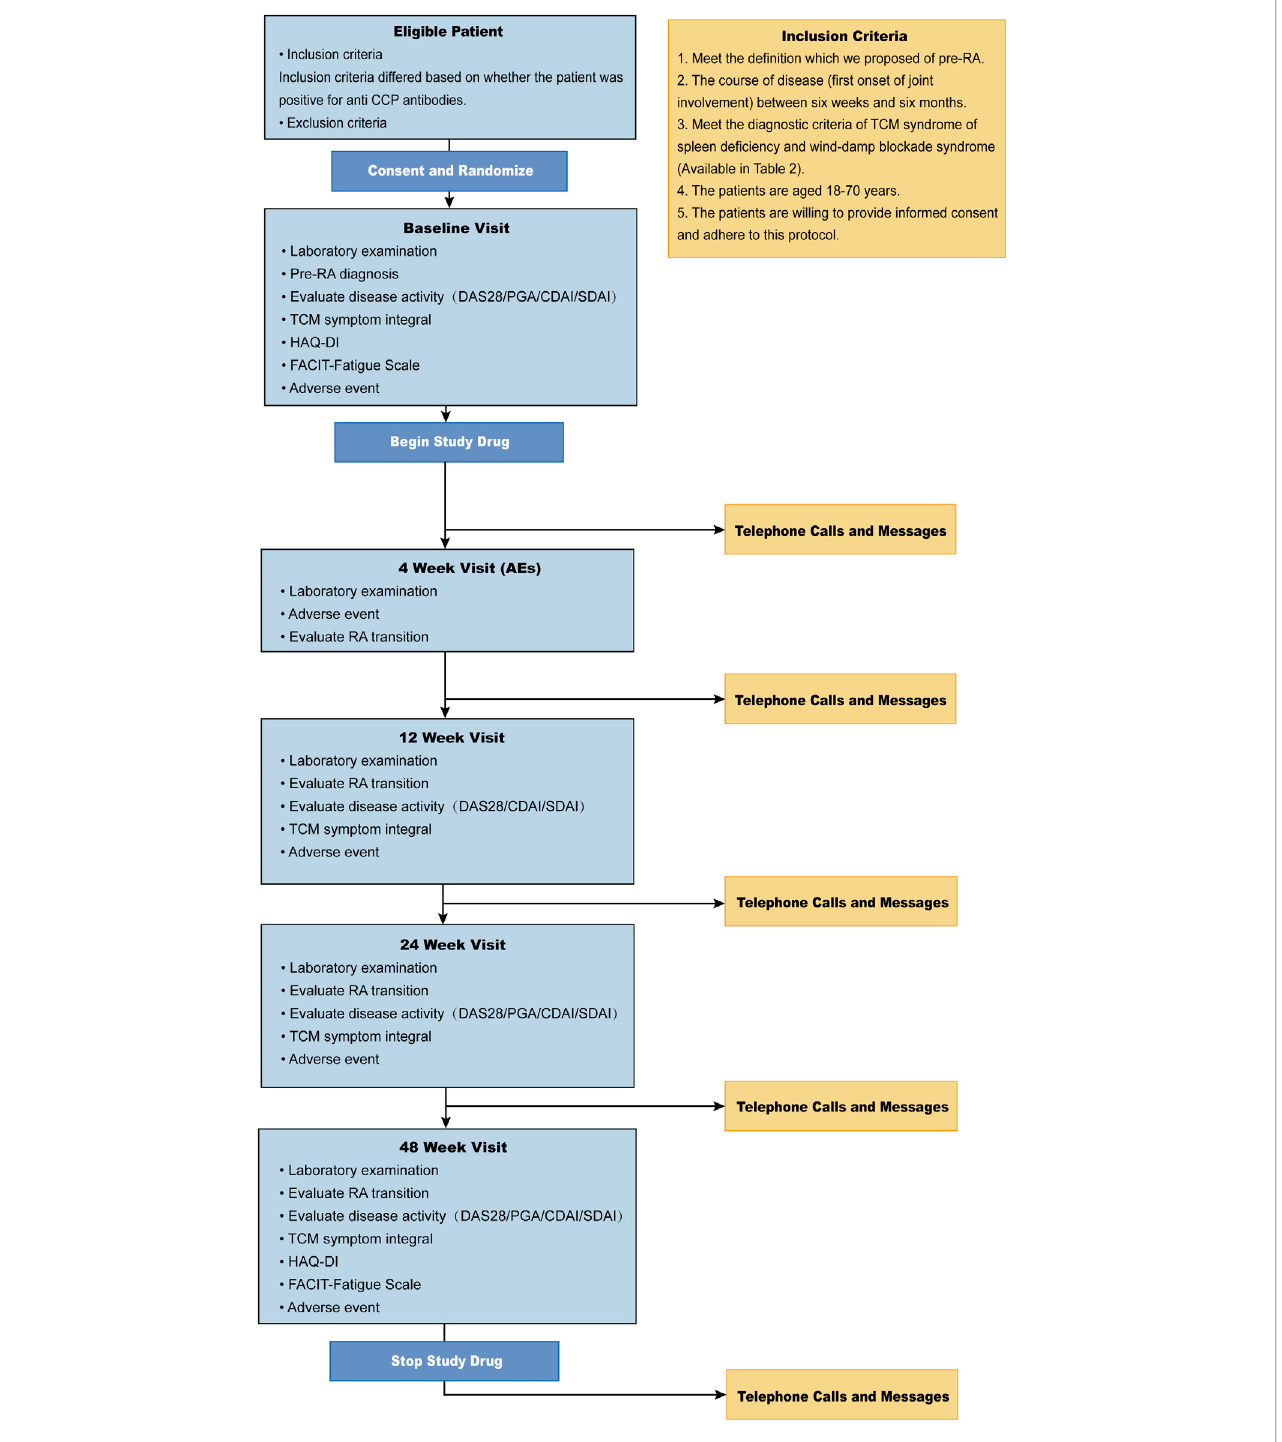
FIGURE 1 | The fl ow diagram of the study.